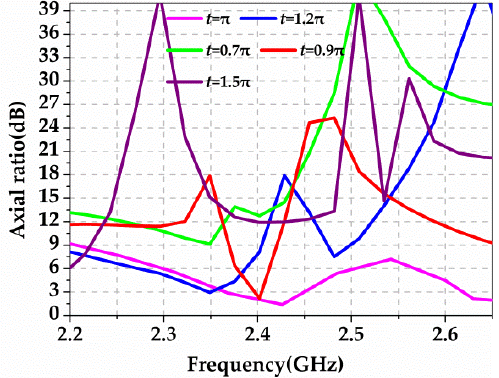
Figure 22. Simulated AR with different values of t .